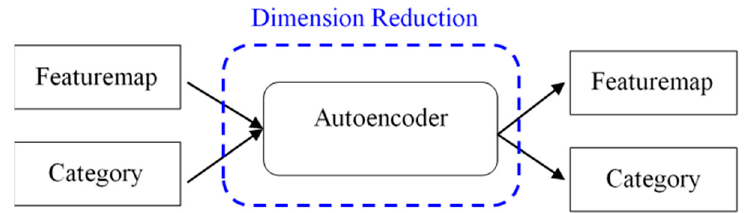
Figure 5. The user preference learning architecture with dimension reduction.